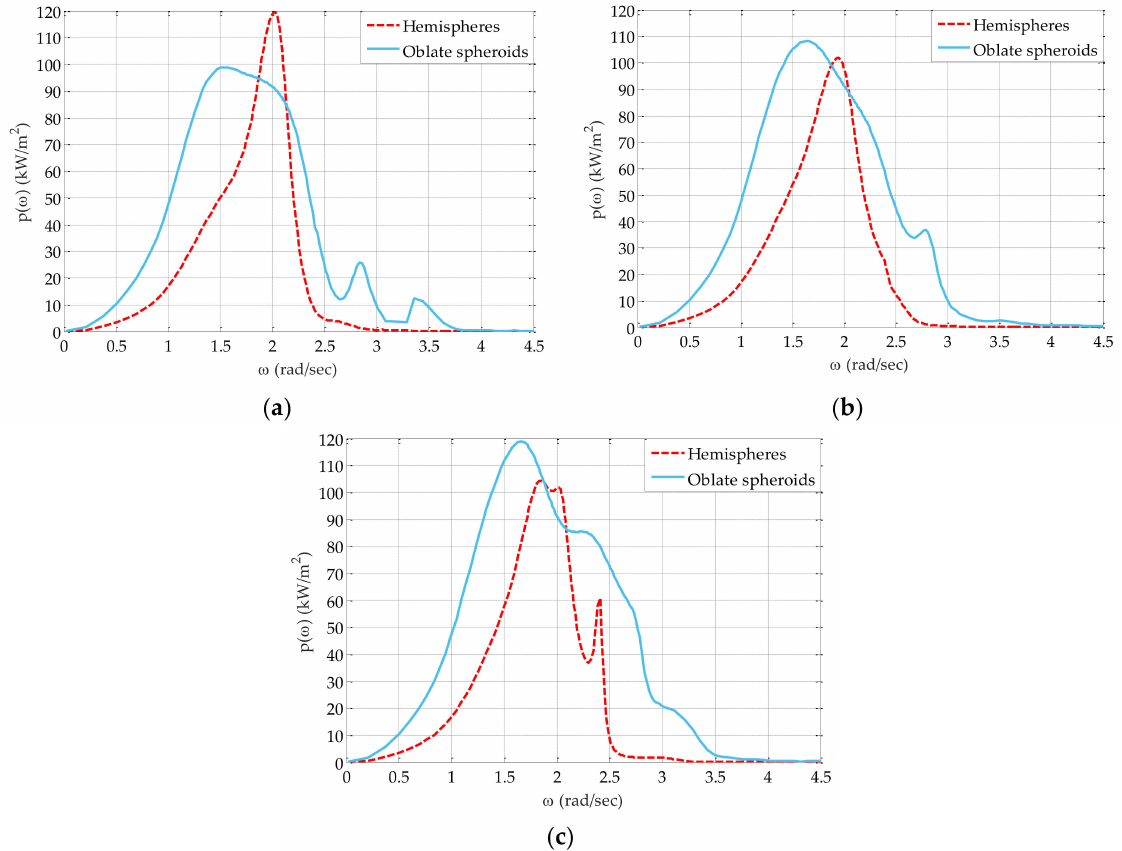
Figure 15. Comparisonof the mean power absorbed by the array with oblate spheroidal ( d net = 0.125 r 0 ) and hemispherical- shaped ( d net = 0.25 r 0 ) WECs for ( a ) β = 0 o ; ( b ) β = 22.5 o ; ( c ) β = 45 o